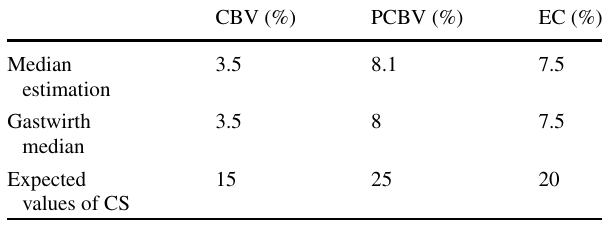
Table 14 Comparison on CS interval